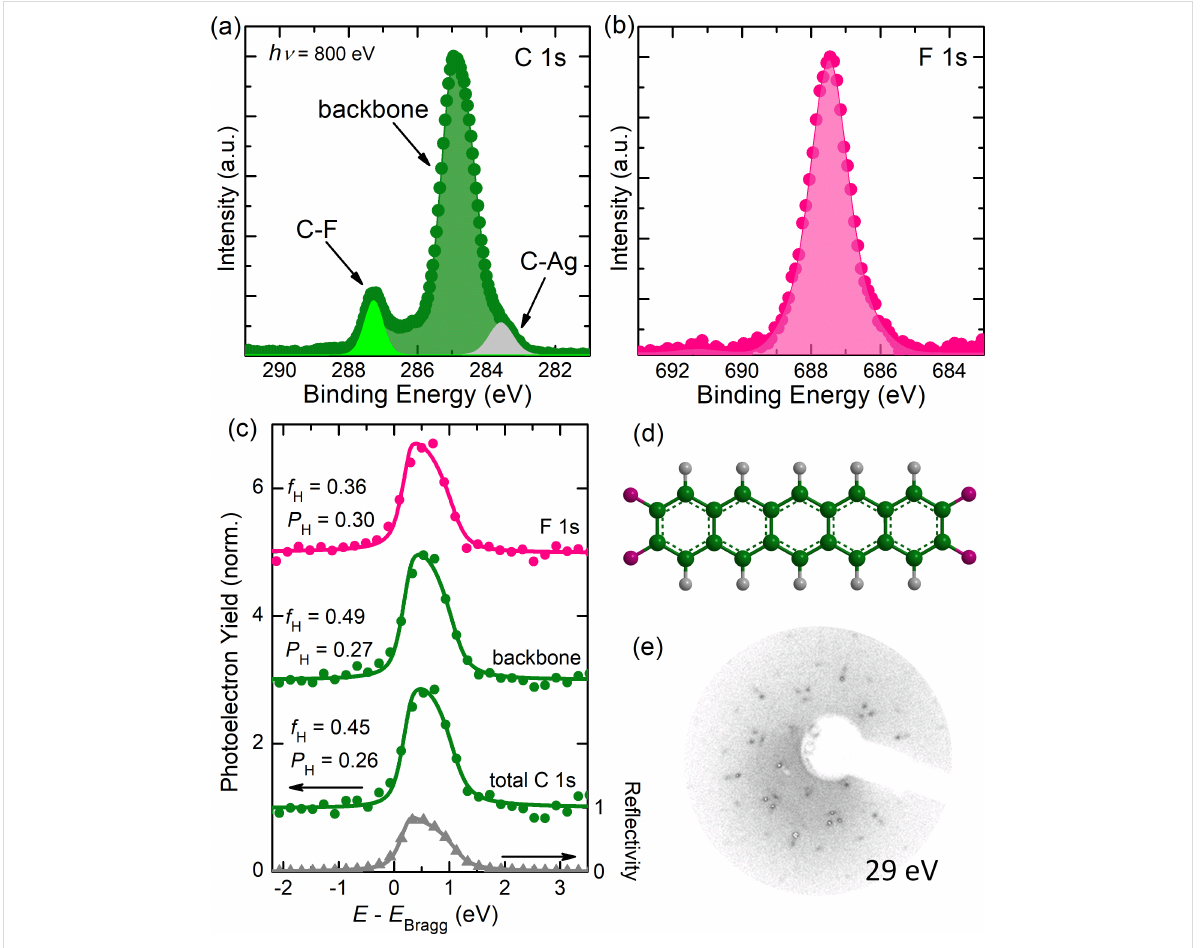
Figure 1: (a) C 1s and (b) F 1s core levels of F4PEN in monolayers on Ag(111) measured at DLS. (c) Reflectivity and photoelectron yield ( Y p ) as a function of the photon energy ( h υ ) relative to the Bragg energy ( E Bragg = 2630 eV) for a (sub)monolayer (<2 Å) F4PEN thin film on Ag(111). For each element, the coherent position ( P H ) and the coherent fraction ( f H ) are given. (d) Chemical structure of F4PEN. (e) LEED pattern for F4PEN on Ag(111) with a nominal thickness of 4 Å, measured at 295 K with a beam energy of 29 eV. The LEED pattern is almost the same as for PEN on Cu(111) [28].